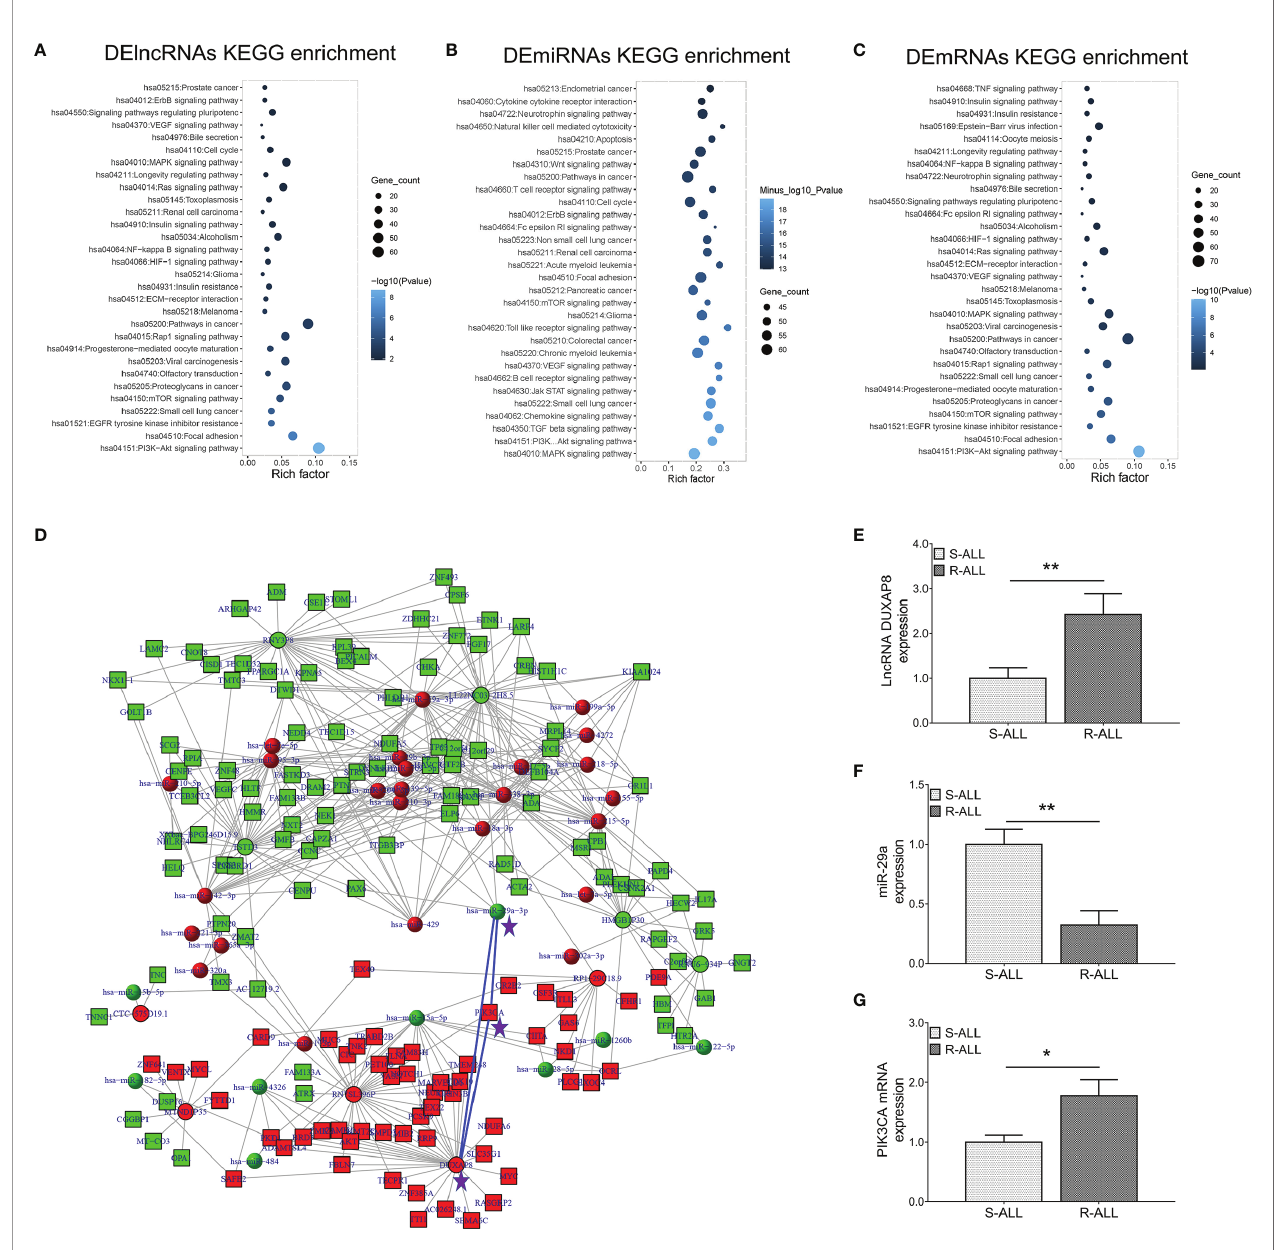
FIGURE 2 | lncRNA – miRNA – mRNA co-expression network and RT-qPCR validation. KEGG (A) enrichment analysis according to DElncRNAs; KEGG (B) enrichment analysis according to DEmiRNAs; KEGG (C) enrichment analysis according to DEmRNAs. LncRNA – miRNA – mRNA co-expression network based on dysregulated genes between R-ALL and S-ALL patients (D) . RT-qPCR detection data of lncRNA DUXAP8 (E) , miR-29a (F) , and PIK3CA (G) expressions between R-ALL and S-ALL